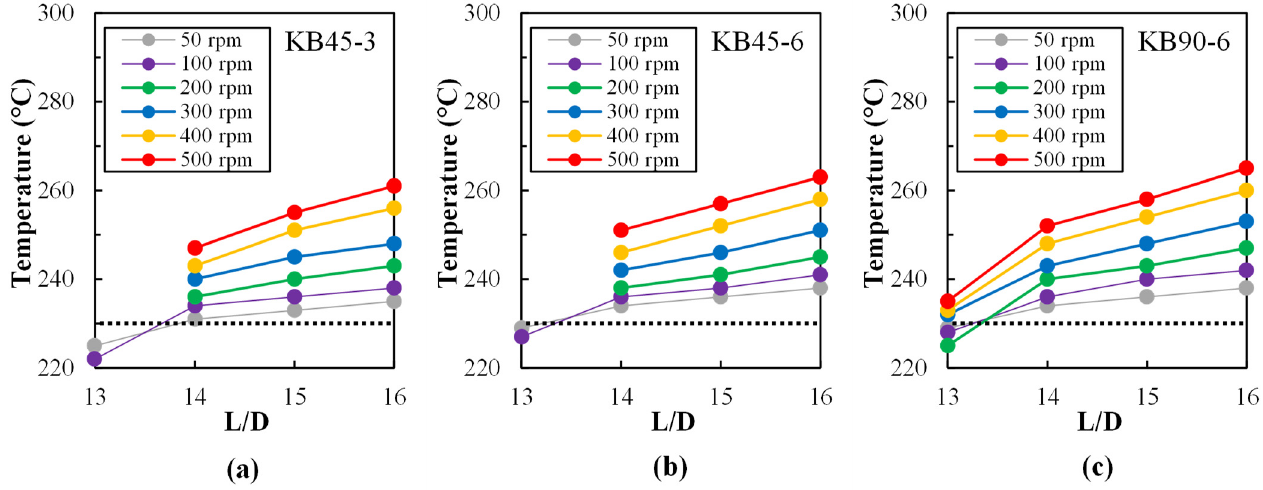
Figure 4. Melt flow temperature (°C) along the mixing zone for various screw speeds (50 to 500 rpm) for each kneading block: ( a ) KB45-3, ( b ) KB45-6, and ( c ) KB90-6. The set extrusion temperature (230 °C) is represented by a horizontal dashed line in each chart.